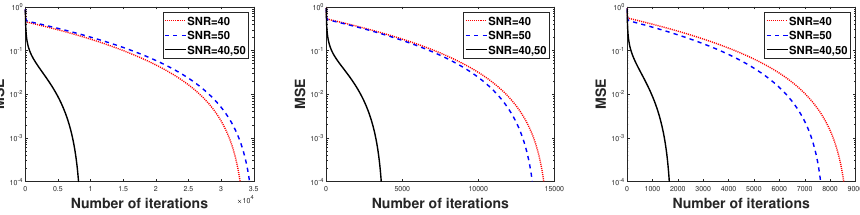
Figure 9. Graph of the number of iterations versus MSE where N = 1024 and M = 512.